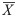
A graphical illustration of the VSI synthetic X¯ chart.The VSI synthetic X¯ chart consists of the X¯ sub-chart and the CRL sub-chart. The short and long sampling intervals are used in the X¯ sub-chart and the CRL sub-chart.